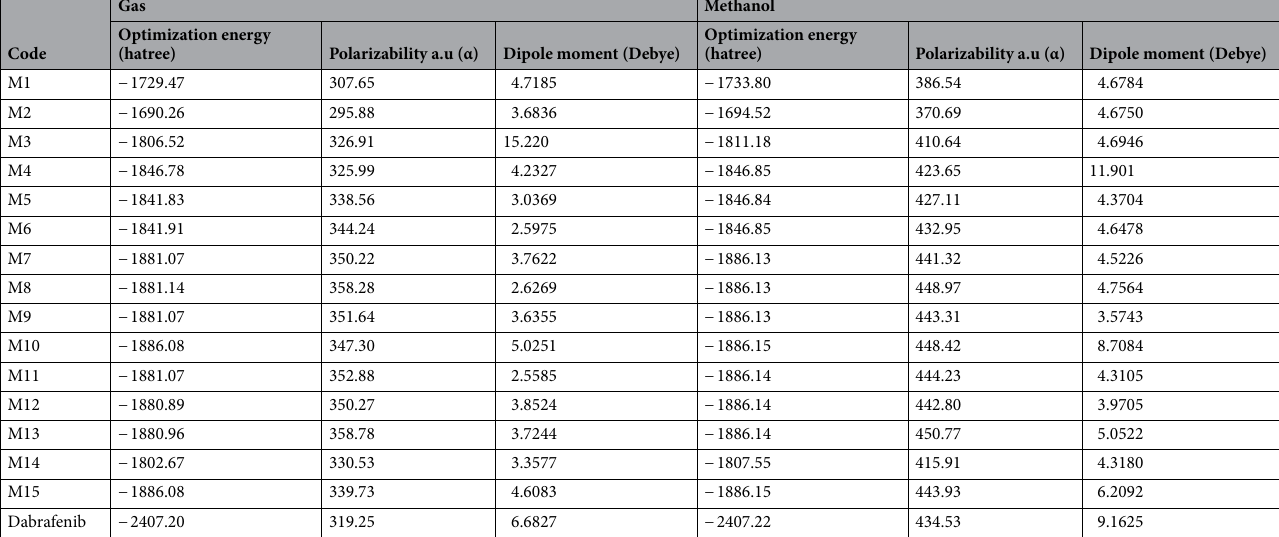
Table 1. Energetic parameters and quantum chemical descriptors for all compounds by using DFT /B3LYP/ SVP method in both gas and in solvent